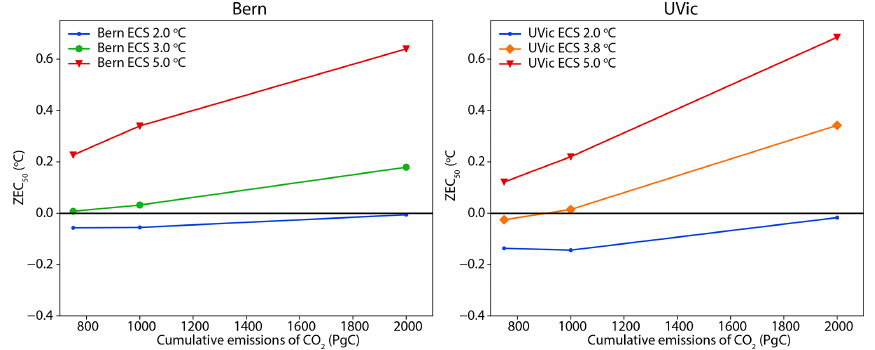
Figure 12. Values of 50-year ZEC for the 750, 1000, and 2000PgC experiments branching from the type A (1%) for versions of Bern and UVic with varying equilibrium climate sensitivity. Note that the ECS values given here are for true equilibrium climate sensitivity and not effective climate sensitivities as used in the remainder of the study.